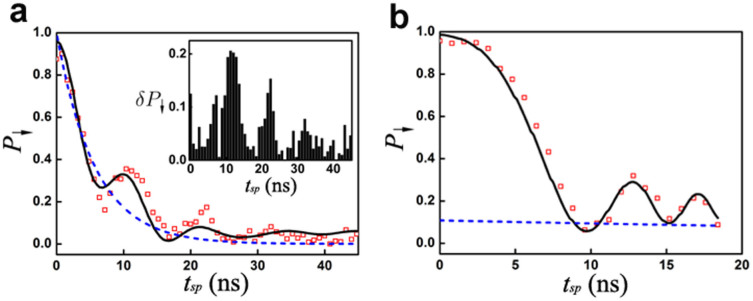
P↓ oscillation at constant LZ speed.(a) Measured P↓ as a function of tsp (the red squares) with εf/2π = 200 MHz which clearly shows oscillation in the region of α < 1 which compares well with the result of numerical calculation (the solid line). This is in stark contrast to the smooth exponential decay expected from the LZ formula (the dashed line). The inset is the difference δP↓ = P↓ − PLZ. (b) The measured (the red squares) and numerically calculated (the solid line) P↓ vs. tsp with constant LZ speed v ≈ 20.5 MHz/ns corresponding to evolving along the yellow dashed line in Fig. 3(a). Again, P↓ oscillates in the region where the adiabatic condition α > 1 is not satisfied which is not expected from the LZ formula (the dashed line).